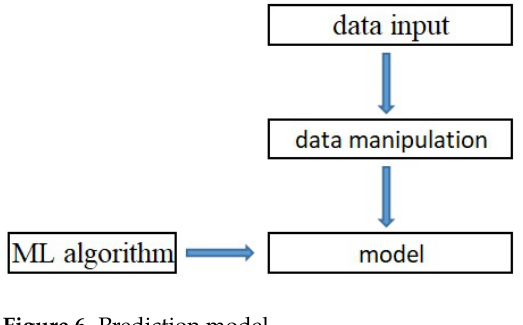
Figure 6. Prediction